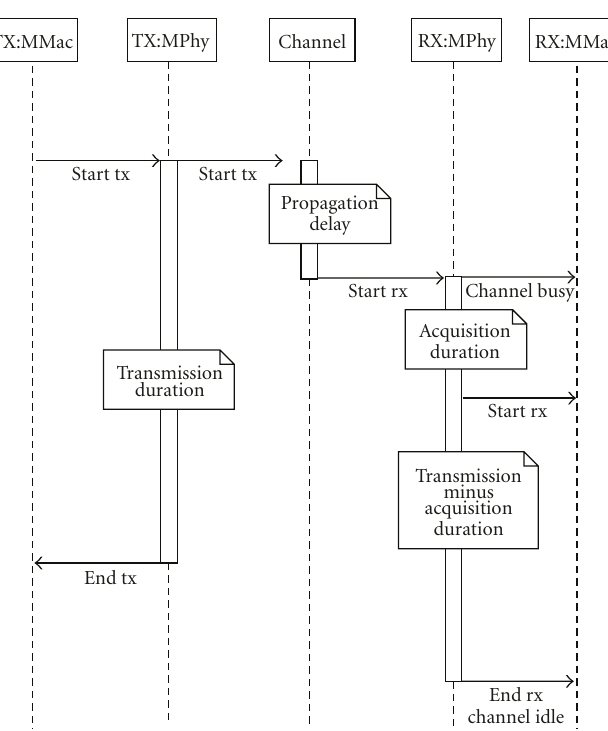
Figure 5: Sequence diagrams for packet TX/RX events in the Miracle Phy and Mac